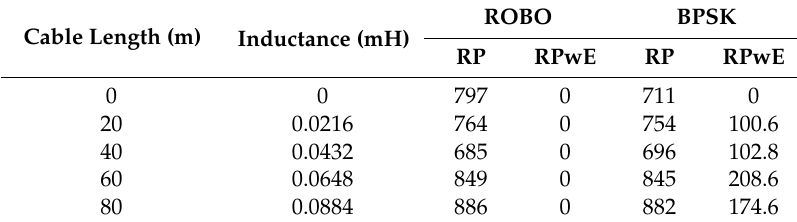
Table 10. ROBO and BPSK Modulations: Lengthening the distance between the receiving modem and the noise source up to 80 m.